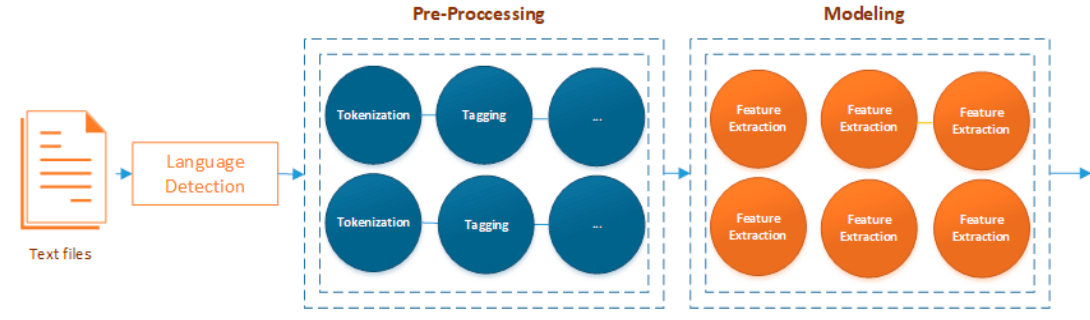
Figure 2. Process identifying ‘surface features’.